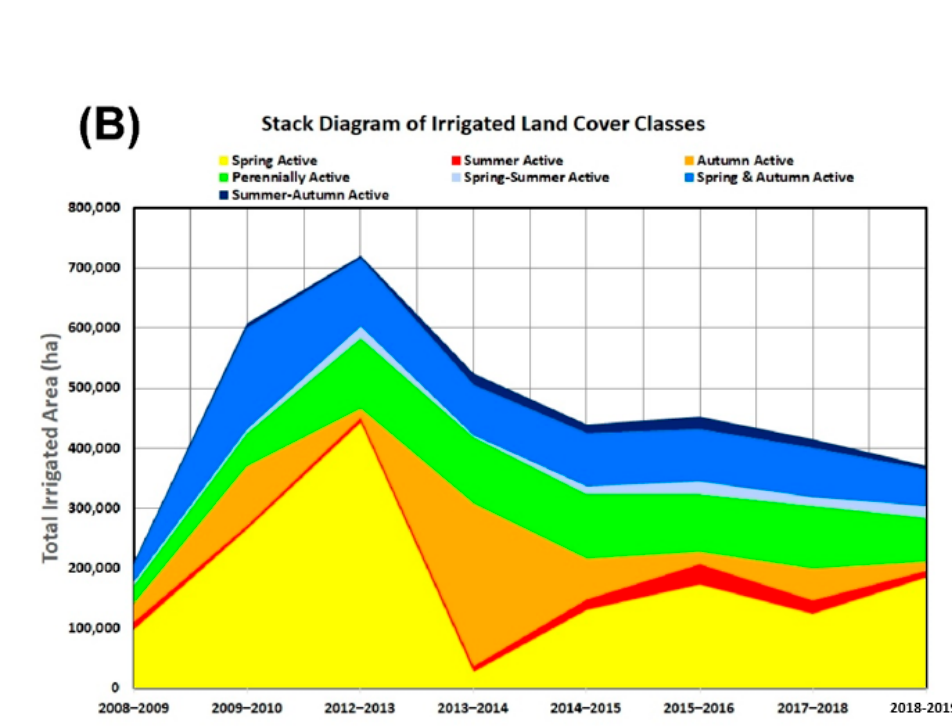
Figure 7. Changes in irrigated land cover in North ‐ Central Victoria from 2008–2009 to 2018–2019. ( A ) Changes in total area over the years. ( B ) Stack diagram showing changes in seven land cover